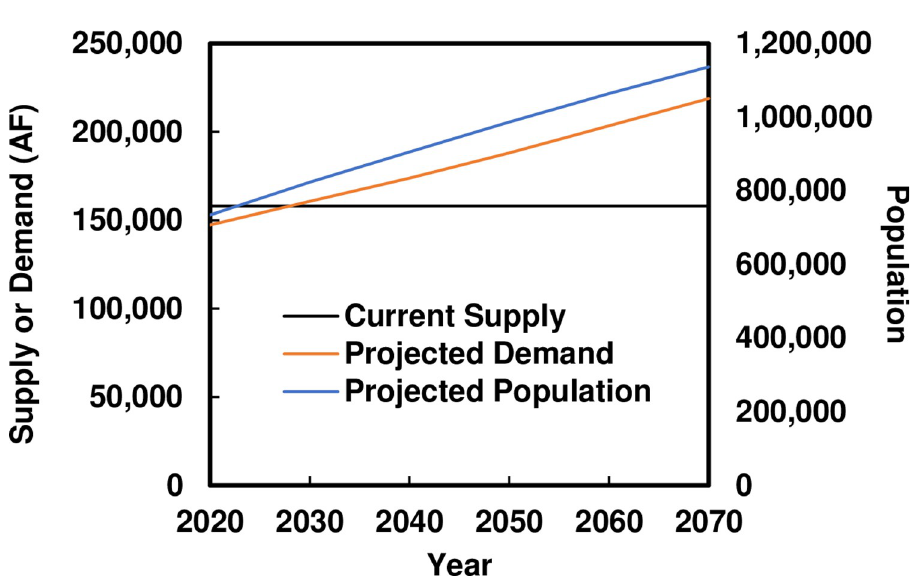
Fig 2. Projected annual water supply and demand and population for the El Paso Water service area from 2020– 2070. The current average annual water supply volume is shown for reference. Source: Work of the authors.